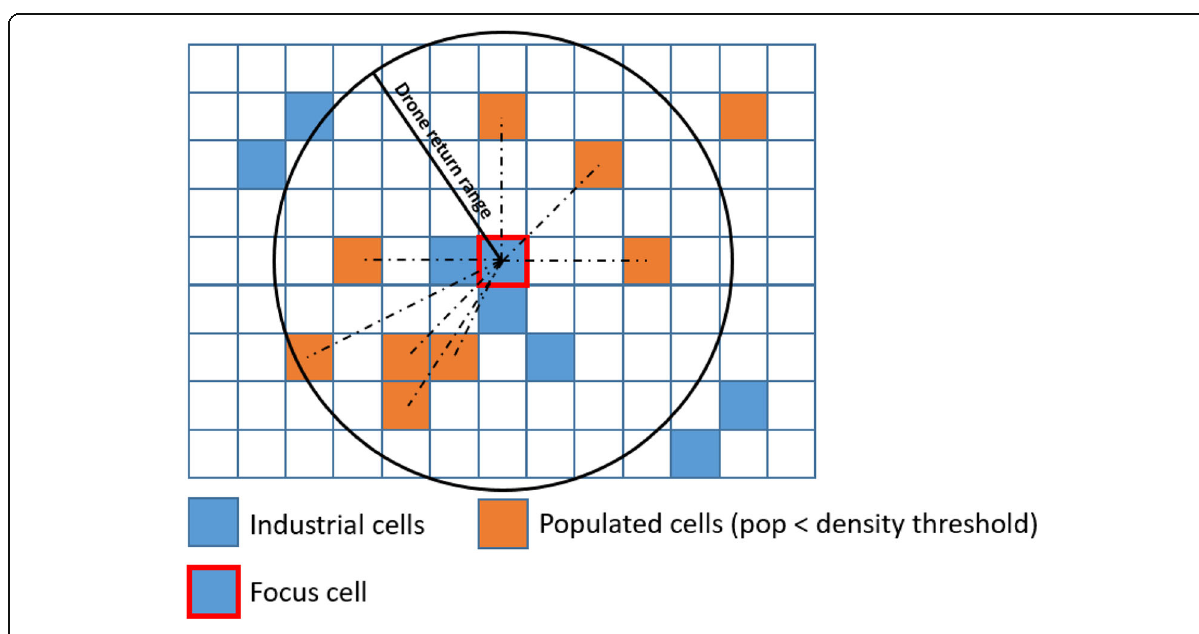
Fig. 4 Illustration of the computational approach